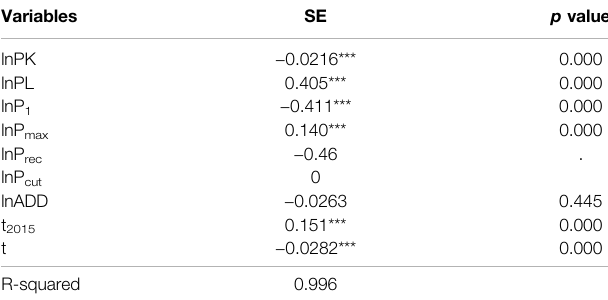
TABLE 5 | The new results of electricity cost share with decomposed